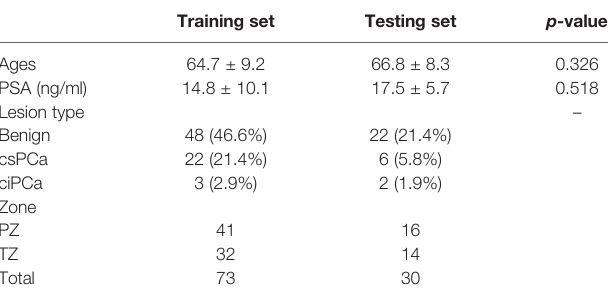
TABLE 2 | Demographic and disease